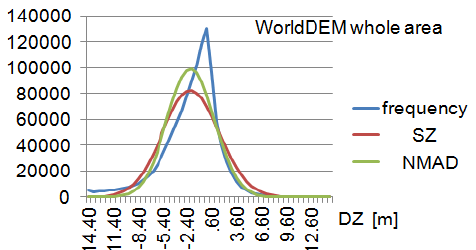
Fig. 18 : Frequency distribution of WorldDEM against LiDAR reference – whole project area